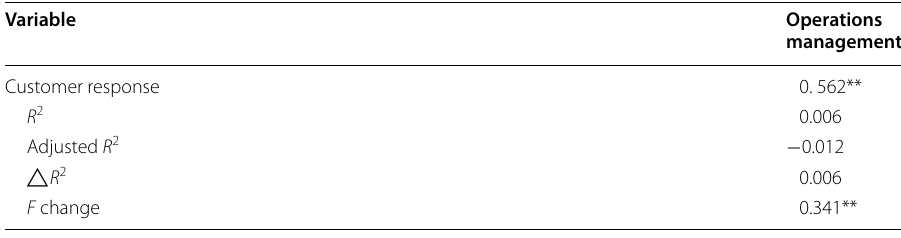
Level of significant: * p < 0.10, ** p < 0.05